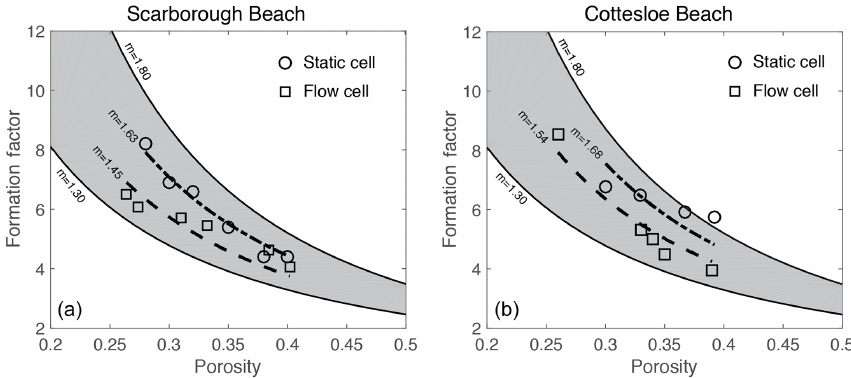
Figure 10. Laboratory-measured formation factor versus porosity values for both the flow and static cells for (a) Scarborough and (b) Cottes- loe Beach samples. Table 1. Summary of laboratory and micro-CT scan image results from the Scarborough Beach samples.